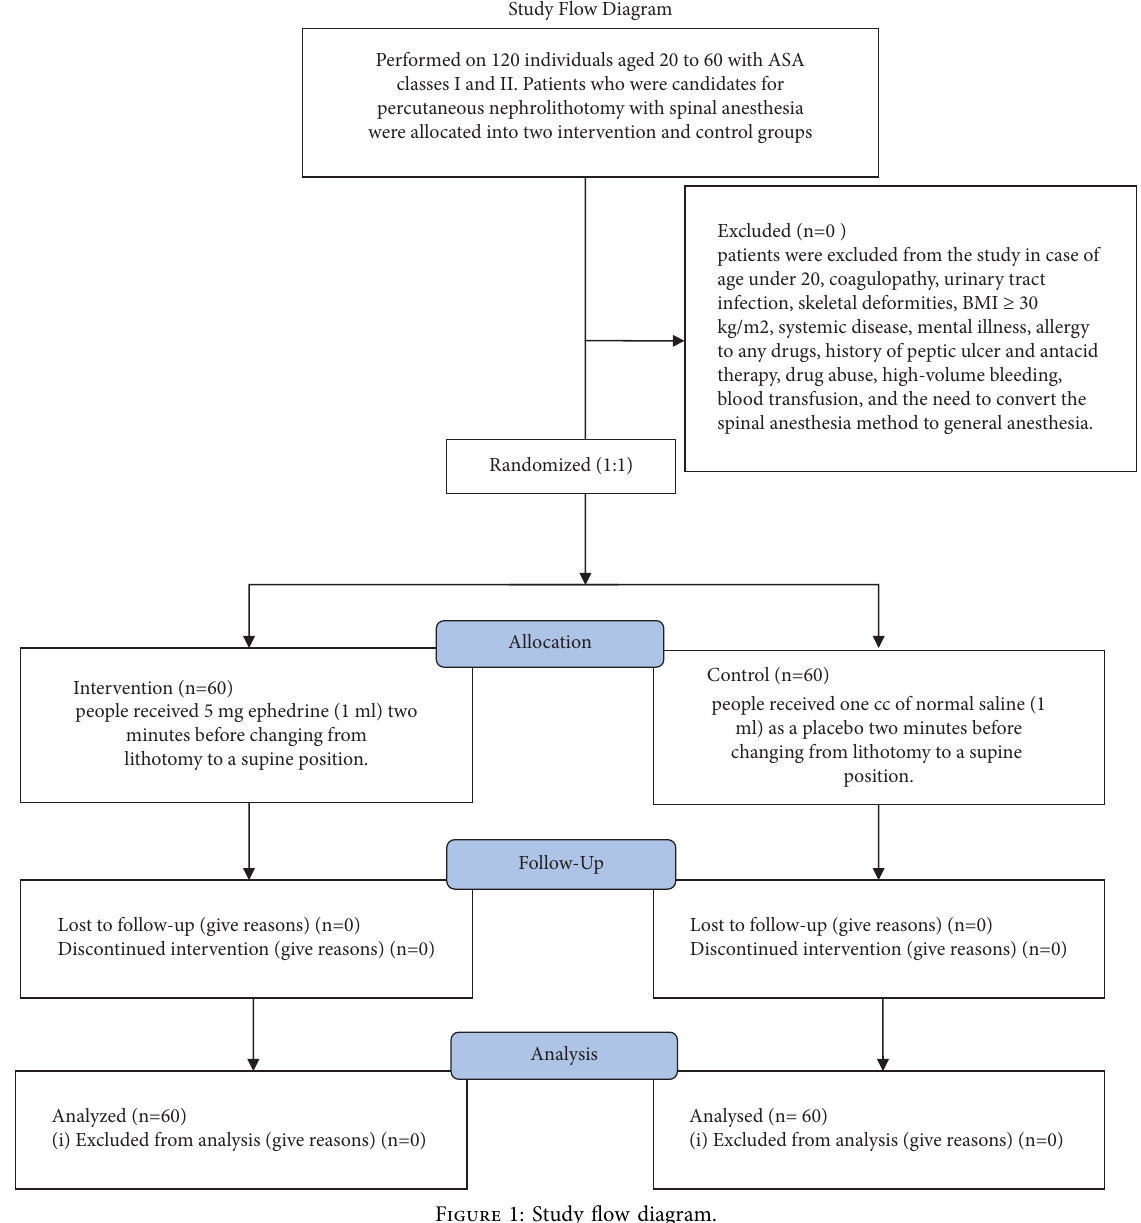
Figure 1: Study fow